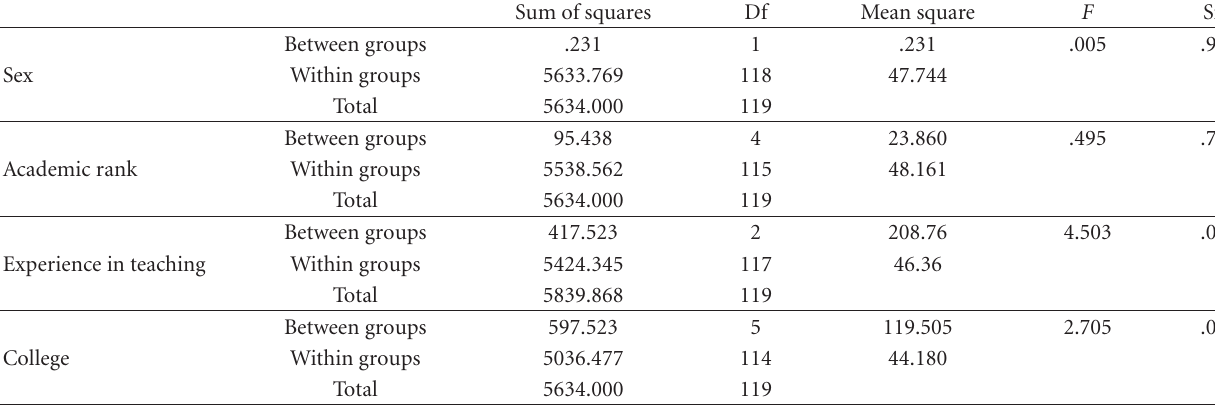
Table 7: The significance mean di ff erence in attitudes score of respondents with respect to the variables, sex, academic rank, and college/schools.